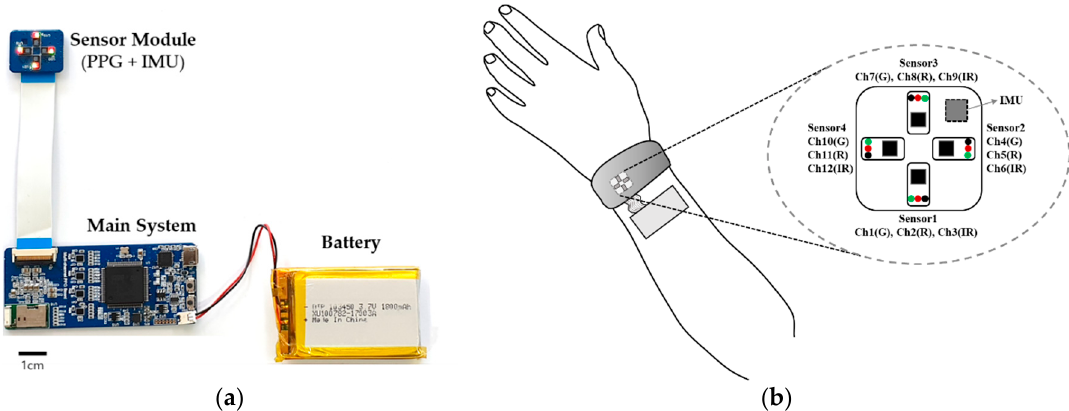
Figure 1. In-house-built wearable multi-channel PPG acquisition system: ( a ) wearable PPG hardware system consisting of a main system, sensor module (PPG and IMU), and battery; ( b ) the direction and wavelength (G: green; R: red; IR: infrared) of the sensor for each channel when the wearable system is worn on the wrist.